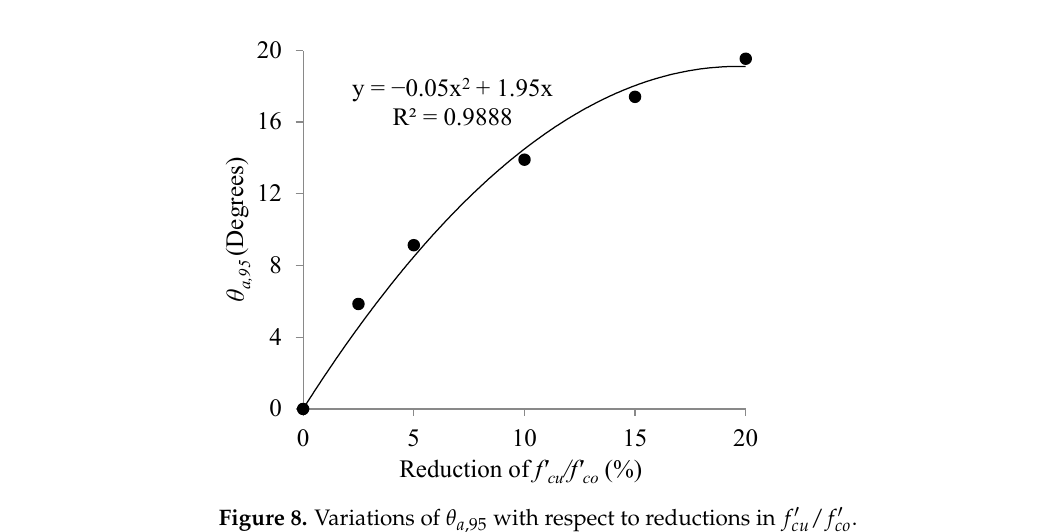
Table 8. Fiber orientations corresponding to different reductions in f (cid:48) cu / f (cid:48) co for each value of E frp .